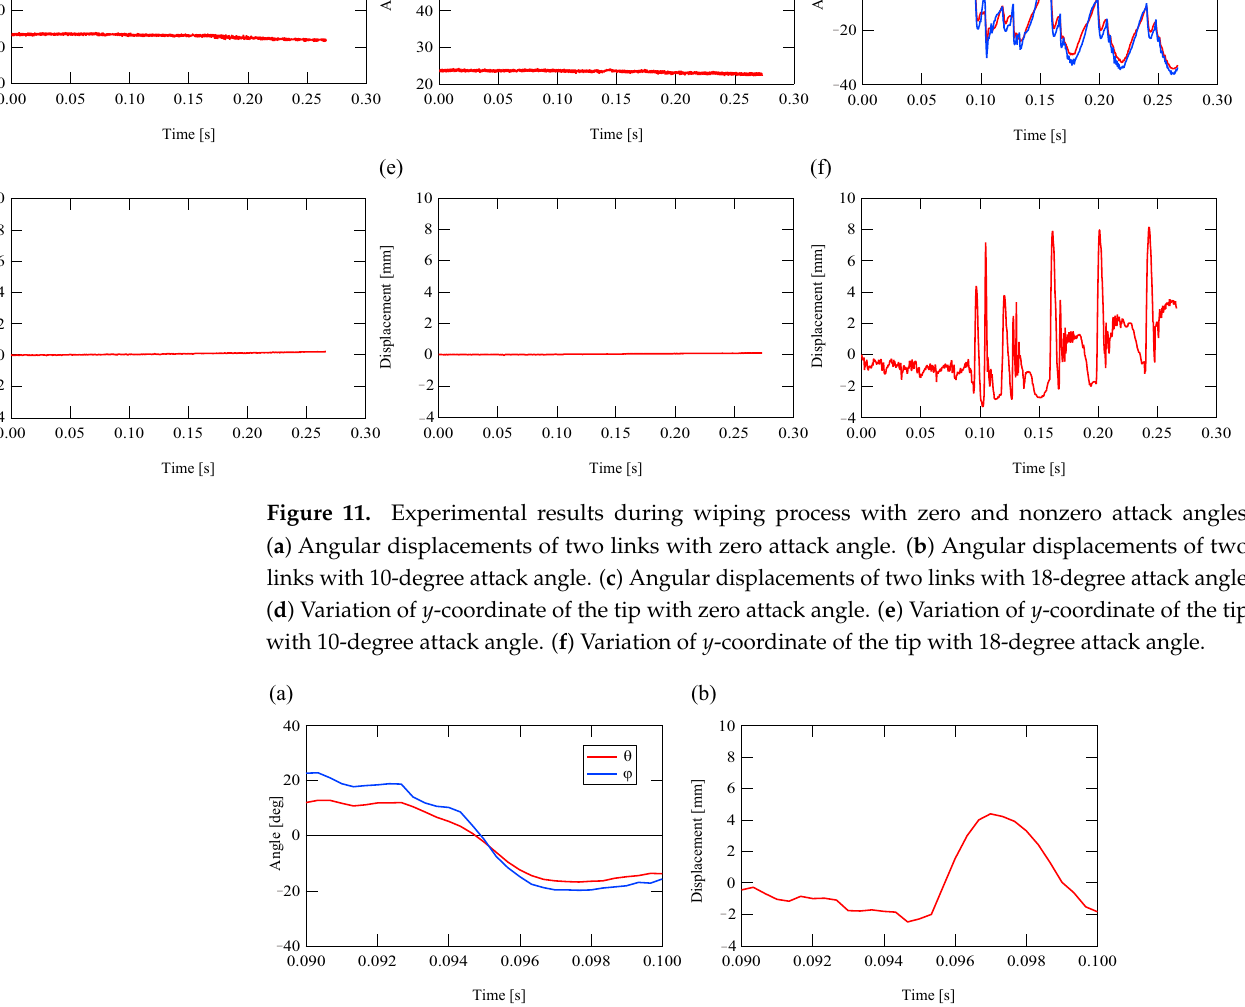
Figure 12. Enlarged view of Figure 11c,f from 0.09–0.1 s. Panels ( a ) and ( b ) correspond to Figure 11c,f,